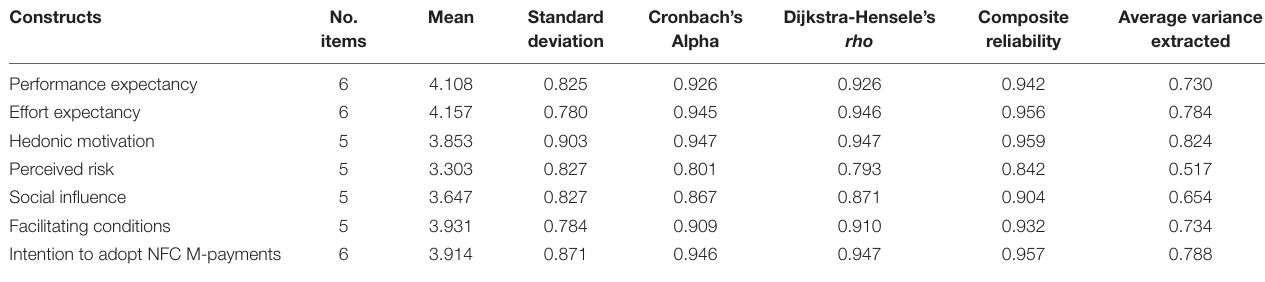
TABLE 2 | Validity and